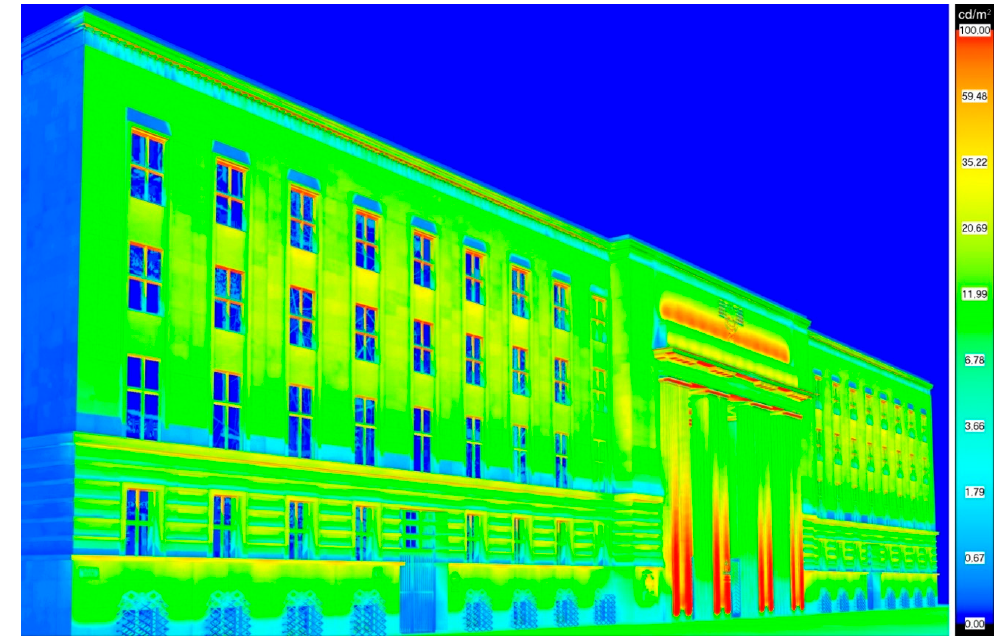
Figure 8. Computer-generated luminance distribution on virtual object.